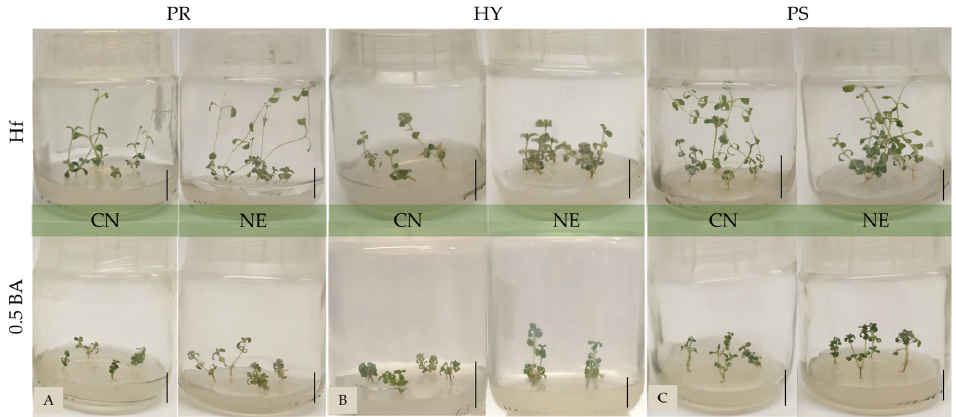
Figure 2. Establishment phase — in vitro regeneration of three C. candidissimum populations by cotyledonary-node (CN) and stem-node (NE) explants, after 50 days, on Murashige and Skoog media either hormone-free (Hf) or supplemented with 6-benzyladenine (BA) at 0.5 mg L − 1 : ( A ) Parnitha population (PR); ( B) Hymettus population (HY); ( C ) Parnassos population (PS). Bars represent a length of 1.0 cm.